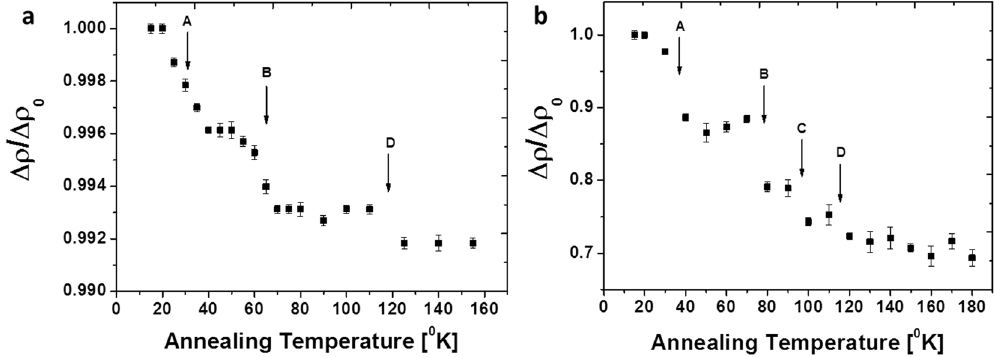
Figure 6. Isochronal annealing measurements (10 min annealing steps). ( a ) Pre-annealing. ( b ) Post-thermal treatment at 548 °K for 3 hr.